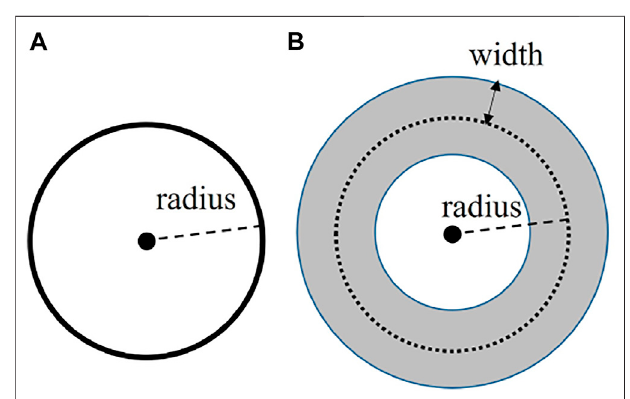
FIGURE 2 | Schematic diagrams of (A) : a circle, i.e., a ring with no width and (B) :anannulus,i.e.,aringwitha fi nitewidth.Here,theradiusofthedotted circle is conventionally regarded as the radius of the